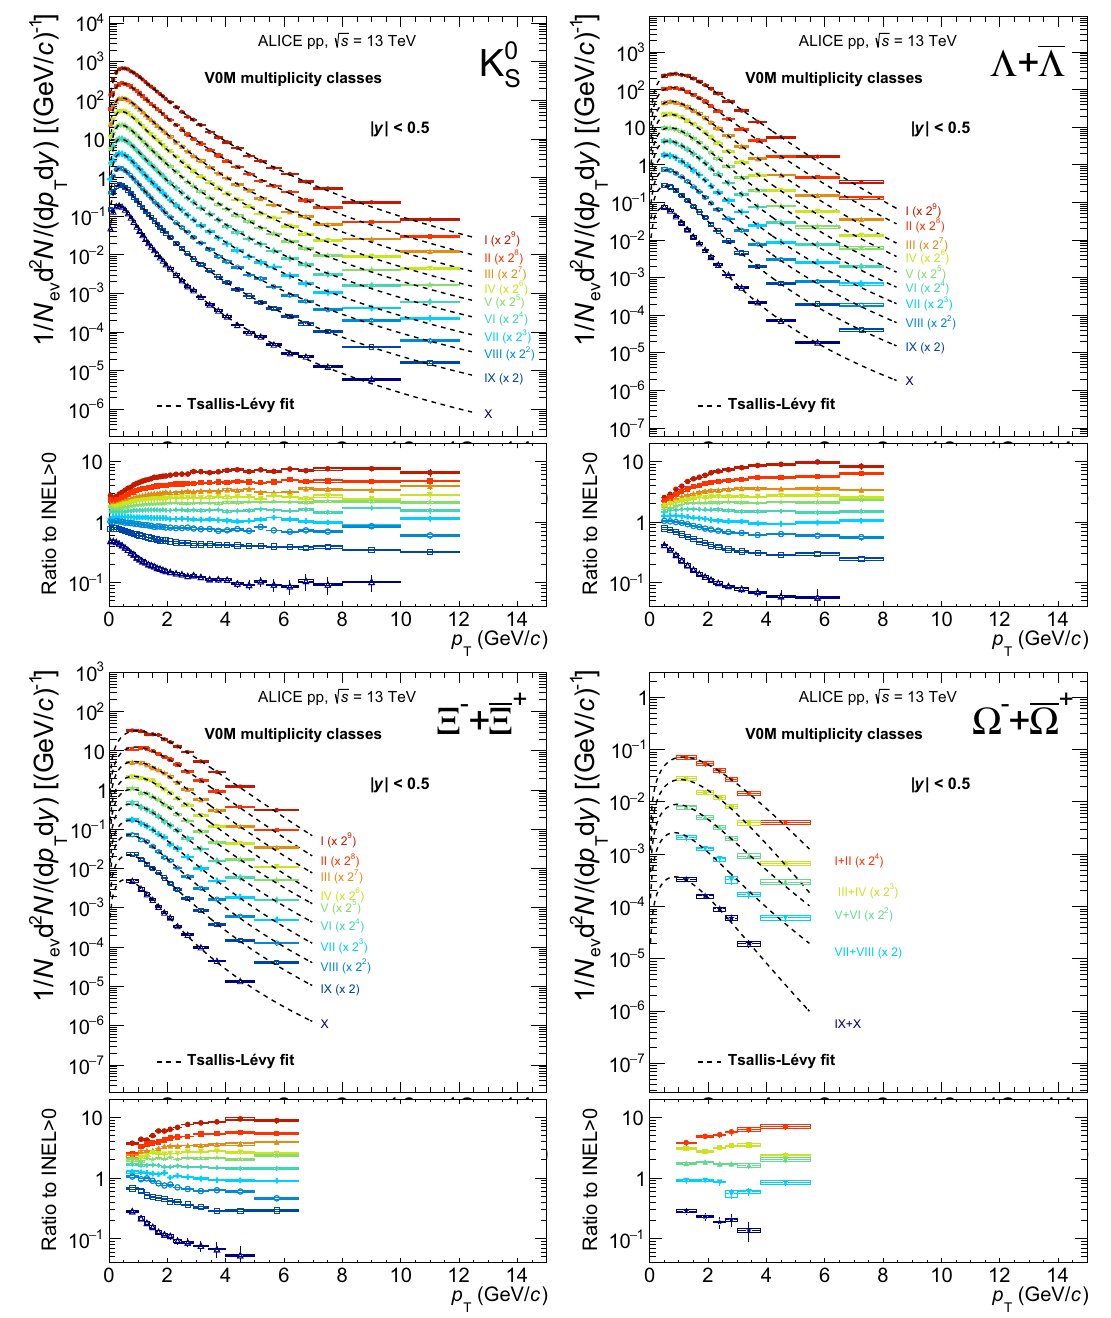
Fig. 2 Transverse momentum distribution of K 0 obtained by considering only contributions uncorrelated across multi- , (cid:3) , (cid:4) , and (cid:5) , for S plicity. The spectra are scaled by different factors to improve the vis- multiplicity classes selected using the V0 detector. Statistical and total ibility. The dashed curves represent Tsallis–Lévy fits to the measured systematic uncertainties are shown by error bars and boxes, respec- tively. In the bottom panels ratios of multiplicity dependent spectra to INEL > 0 are shown. The systematic uncertainties on the ratios are